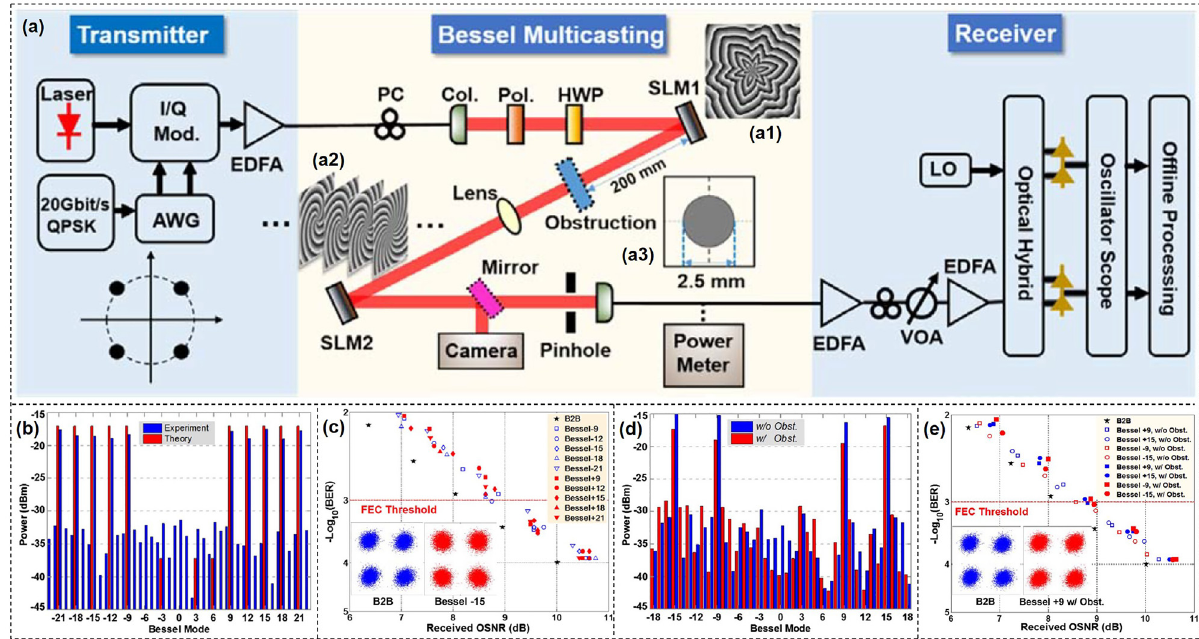
Figure 18: N -fold Bessel beams multicasting. (a) Experimental setup of N -fold Bessel beams multicasting. (a1) Phase pattern for generating multiple Bessel beams. (a2) Phase pattern for back converting a Bessel beam to a Gaussian-like beam. (a3) Obstruction pattern. (b) Measured and theoretical power distribution for 10 Bessel beams multicasting ( l = ± 9, ± 12, ± 15, ± 18, and ± 21). (c) Measured BER performance of all channels ( l = ± 9, ± 12, ± 15, ± 18, ± 21) for 10 Besselbeamsmulticasting.(d)MeasuredandtheoreticalpowerdistributionforfourBesselbeamsmulticasting( l = ± 9and ± 15).(e)Measured BER performance for four Bessel beams multicasting with and without obstruction [121]. Reprint permission obtained from